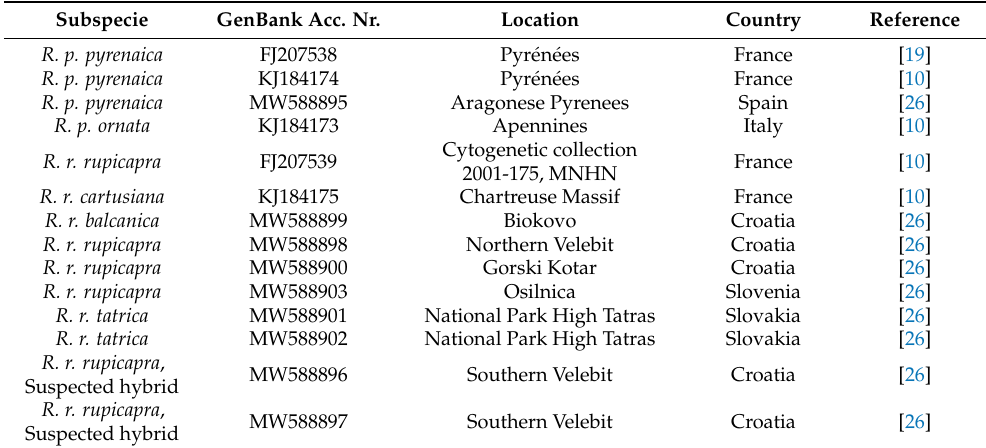
Table 2. Information about the origin and GenBank accession numbers of the sequences retrieved from the